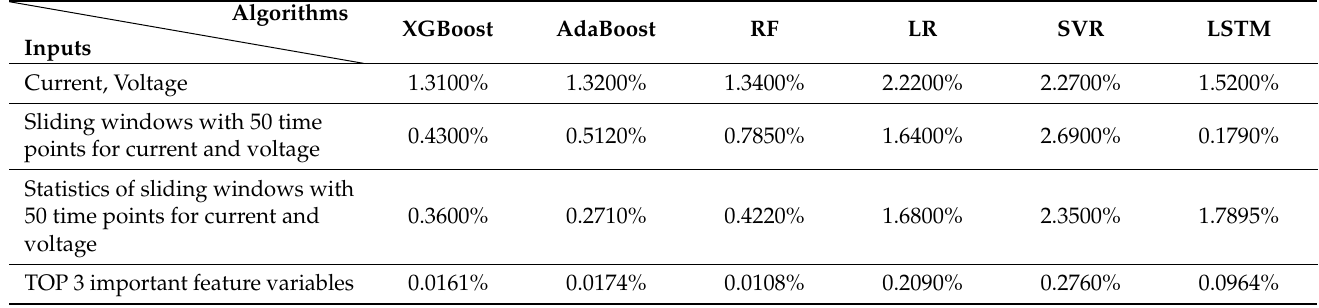
Table 2. Comparison of algorithms’ RMSE when selecting different input